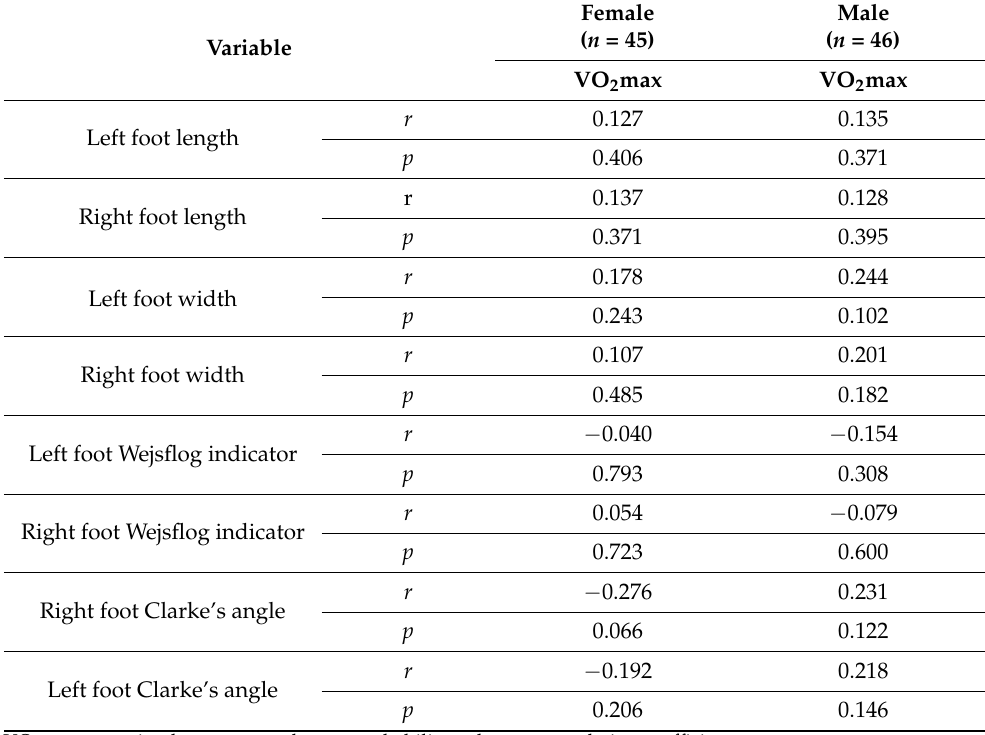
Table 4. Results of Pearson’s r correlation test examining relationships between maximal oxygen uptake and feet somatic characteristics.